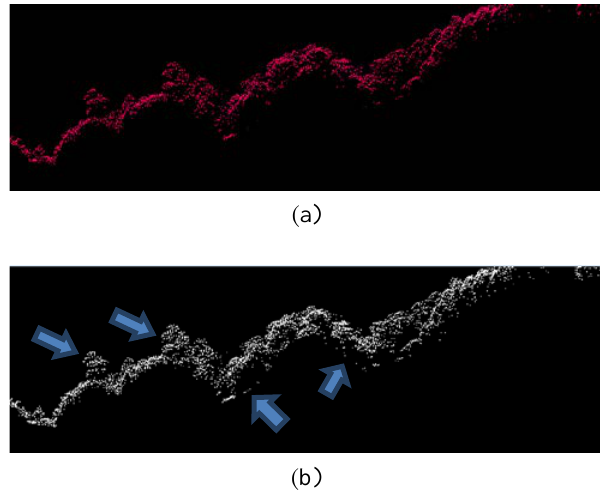
Figure 11. The side view of a selected profile. (a) points provided from the instrument, (b) points extracted from waveforms using the wavelet-based detector. The arrows show some of the extra-points detected by our